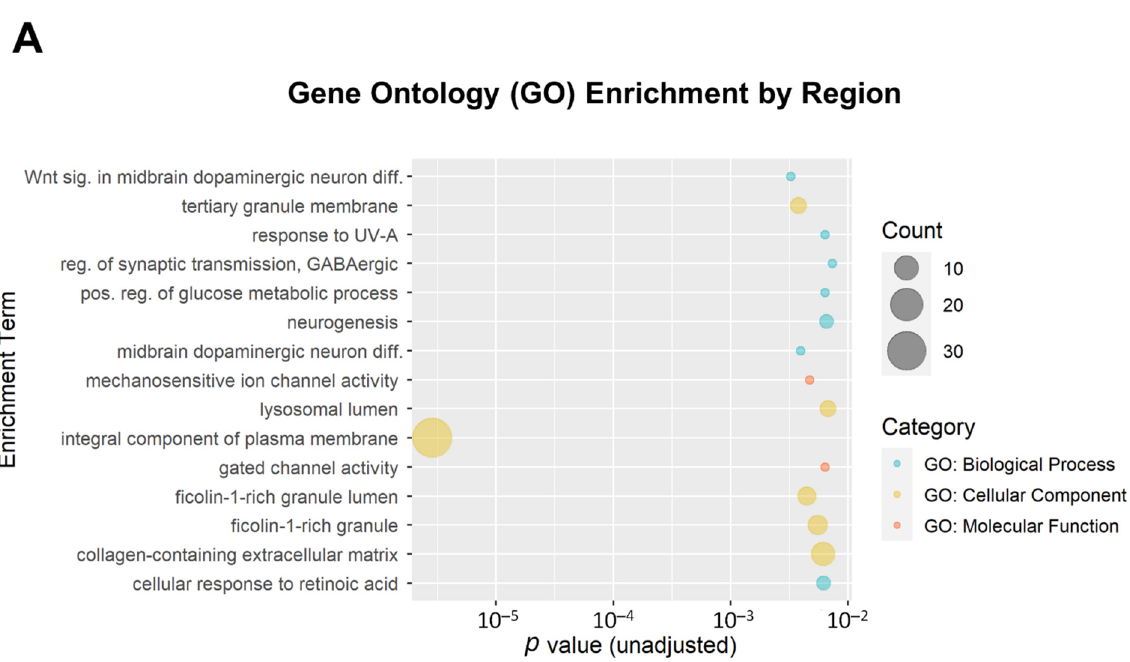
Figure 7. Bubble plots of gene enrichment results from the top differentially methylated regions associated with opioid exposure. A total of 199 DMRs (minimum smoothed FDR < 0.05) mapped to 174 genes that were used as input for the enrichment analysis. ( A ) The top 15 Gene Ontology (GO) enrichment terms. GO terms are color-coded by subcategory (Biological Process, Molecular Func- tion, or Cellular Component). All unadjusted p ≤ 0.007. ( B ) The top 9 Kyoto Encyclopedia of Genes and Genomes (KEGG) enrichment terms. The size of the bubble for each enrichment term corre- sponds to the number of enriched genes within that pathway.